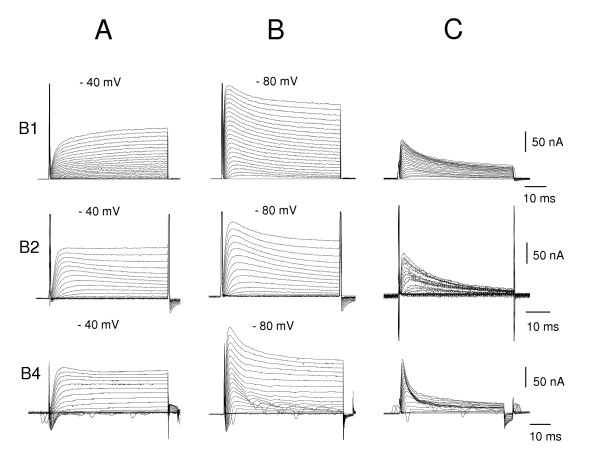
A series of voltage-activated current traces of B1, B2, B4 motoneurons evoked by 5 mV depolarizing voltage steps between -60 mV and +40 mV. A. From a holding potential of -40 mV, initial fast inward current (seen on B2 and B4) is followed by a slowly activating outward current (B1, B2, B4 cells) which does not inactivate during the 50 ms current step. B. The same voltage protocol starting from -80 mV holding potential evokes an additional, fast outward current component on all three motoneurons. C. Subtracting the two current records shows the initial transient outward current is a fast inactivating outward current during the course of the 50 ms voltage steps. All experiments in normal saline.